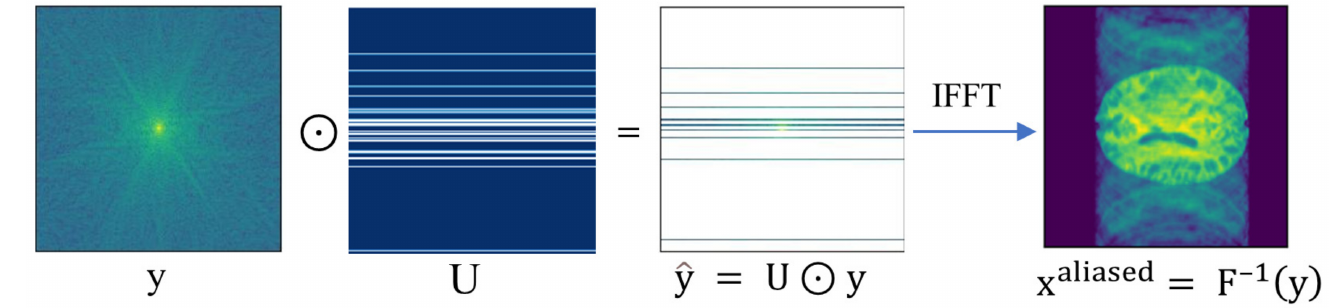
Figure 1. Reconstructed artifact image from sparsely sampled